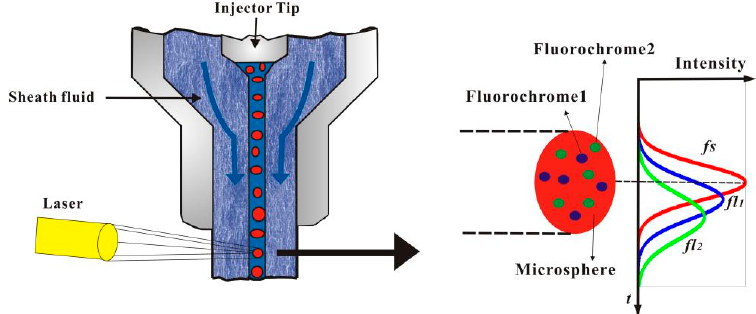
Figure 1. Generation principle of flow pulse signal.